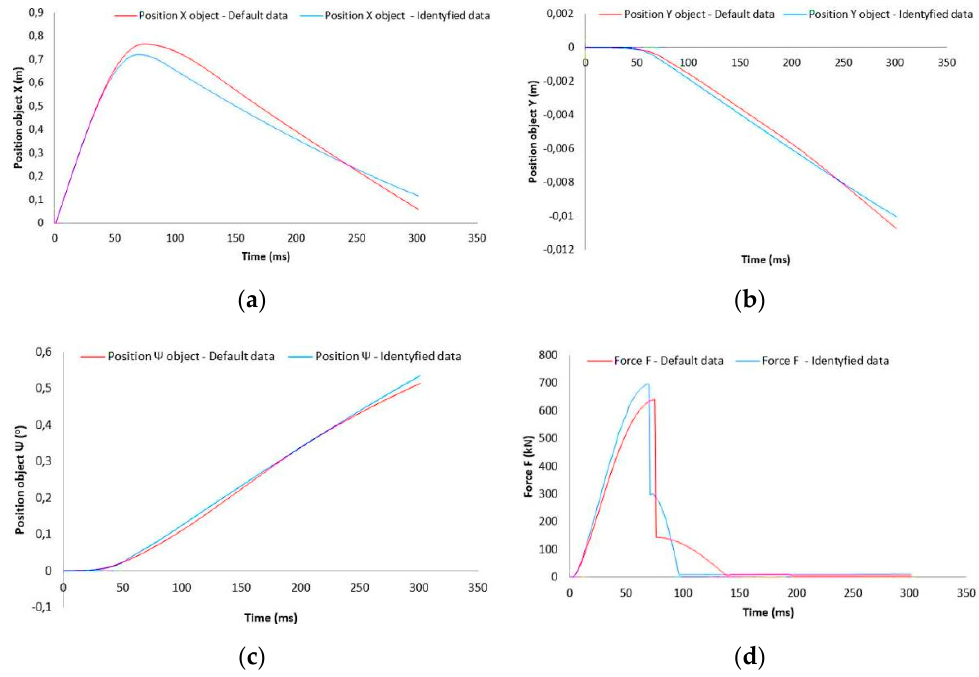
Figure 11. Time histories: longitudinal component X ( a ), transverse component Y ( b ), yaw orientation angle Ψ ( c ), and impact force F ( d ) recorded in V-SIM simulations.